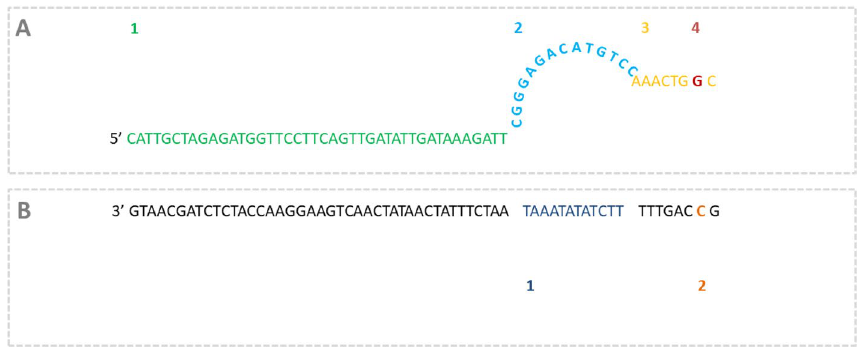
Figure 2. Schematic representation of the Dual Priming Oligonucleotide (DPO) forward primer ( A ) for the detection of wciPα and the target 6A/C sequence ( B ) as an example of the DPO designs used in this study. DPO primers combine the thermodynamic advantages of two priming regions, a short highly specific ‘foot’ sequence terminating at the 3’ end, and a longer stable and sensitive 5’ ‘anchor’ sequence with their action separated by a non-complimentary ‘bridge’ sequence that forms a bubble. The ‘bridge’ keeps the highly specific foot sequence close to the target sequence by connecting it to the anchor, increasing the frequency of target-primer hybrid formation to enable highly specific primer extension. Due to the dual priming nature of these oligonucleotides, the extension will not proceed if the 3’ short foot sequence is mismatched. A1 shows the ‘anchor’ sequence which is the first priming region, A2 is the ‘bridge’ sequence which is non-complimentary to the intervening sequence (B1) which is not a priming region and the second priming region with the ‘foot’ sequence (A3) containing the interrogating nucleotide (A4) which targets the SNP on the wciPα target strand (B2).